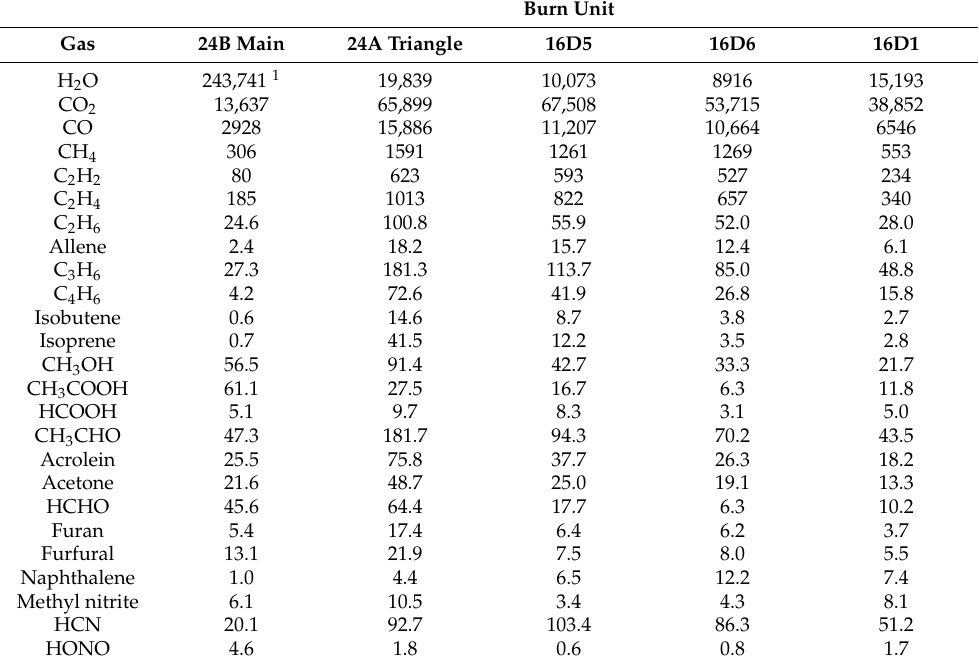
Table 5. Mean pyrolysis gas concentrations (ppm) derived from FTIR measurements for small, prescribed burns at Ft. Jackson, SC, in April 2018. Values are presented as the geometric mean (95 percent confidence